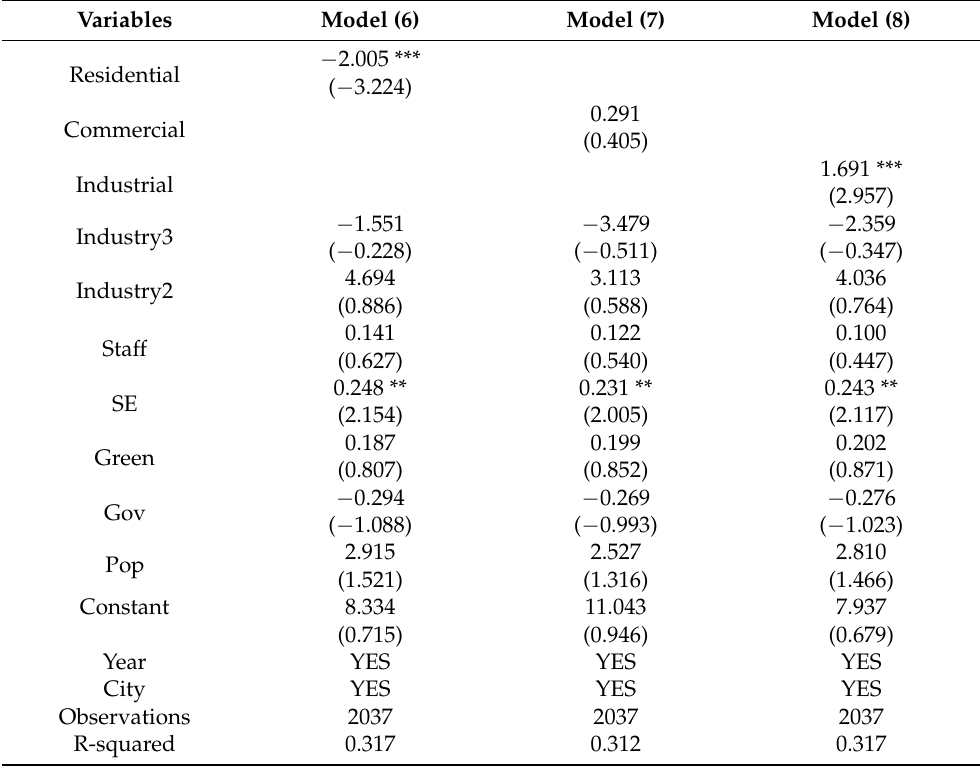
Table 6. Regression results of land transfer structure and urban carbon